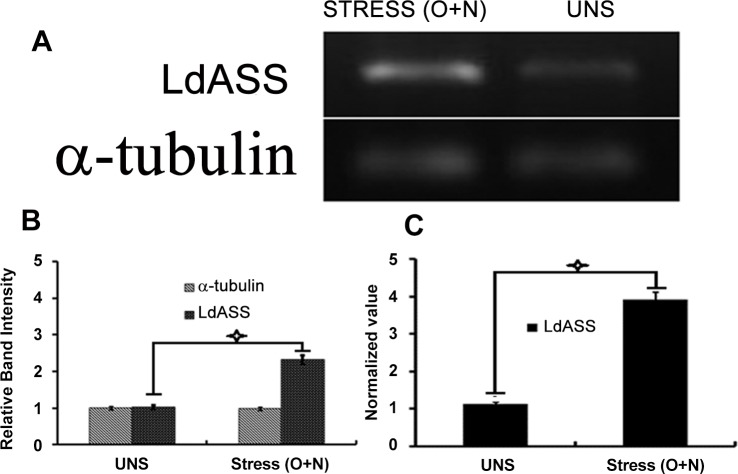
Relative expression levels of the L. donovani ASS in response to oxidative stress.Wild type (WT) L. donovani parasites were treated with a mixture of 2.5 μM menadione and 250 μM SNAP and the relative LdASS mRNA expression levels were measured by semi-quantitative RT-PCR, (A) using promastigotes exposed to an oxidative (O) and nitrosative (N) stress or unstimulated (UNS) control cell. Amplification of a DNA fragment corresponding to α-tubulin was used as the loading control. B) Densitometry analysis of RT-PCR products for LdASS and α-tubulin was performed on ethidium bromide stained agarose gels. Bar diagram showing the LdASS mRNA level was increased by ~2.4-fold in O+N stress cells. C) Real-Time PCR analysis was performed to quantify the LdASS and α-tubulin mRNA levels following oxidative and nitrosative stress (O+N) treatment or unstimulated controls. Bar diagram showing that the ASS mRNA level was increased ~4-fold in O+N stress cells. Each measurement was performed in triplicate and data are expressed as the mean. Vertical lines on top of the bars represent S.E. (standard error) values and star symbol above the vertical lines denotes significant changes with P<0.005.